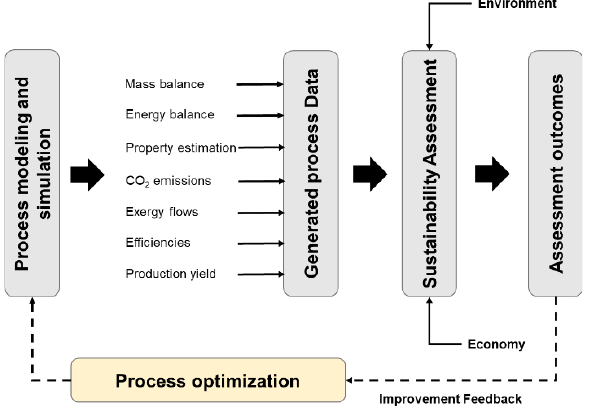
Figure 1. A schematic sustainability assessment approach combining process modeling, simulation, and optimization.